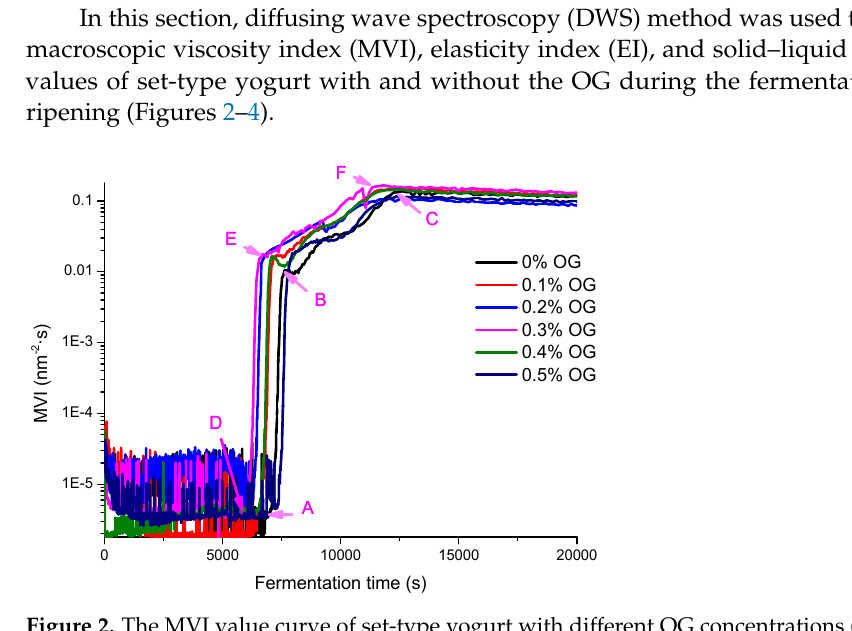
Figure 2. The MVI value curve of set-type yogurt with different OG concentrations (0%, 0.1%, 0.2%, 0.3%, 0.4%, and 0.5%) during fermentation.